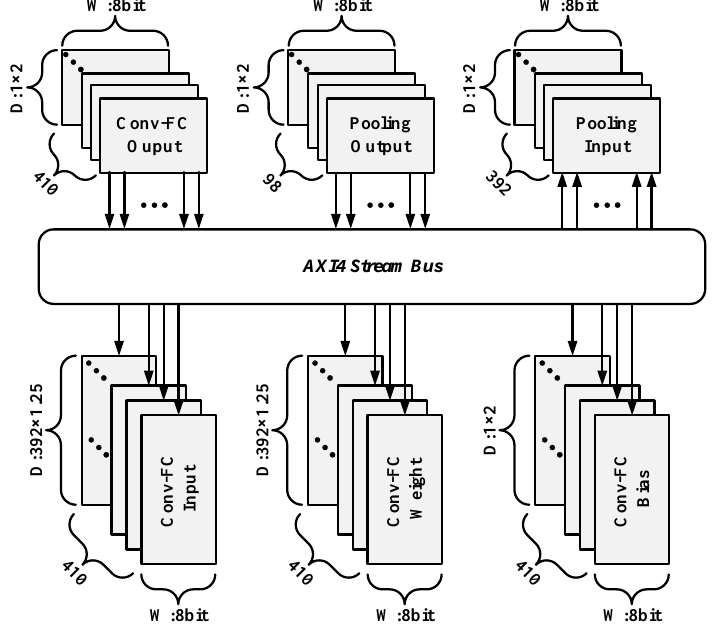
Figure 15. On-chip Memory System.